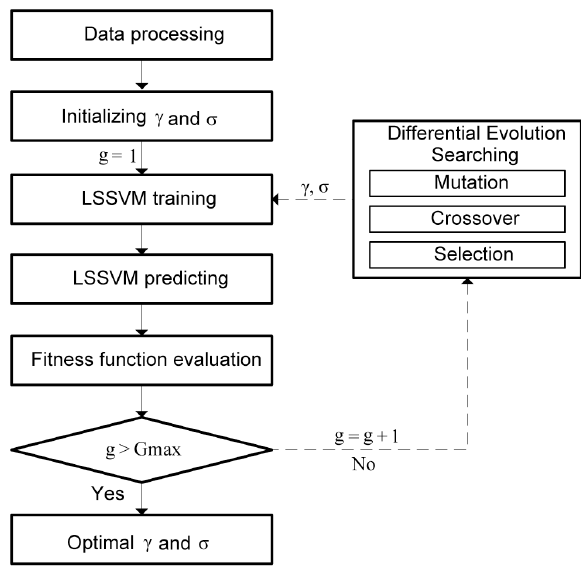
Fig. 4. Differential Evolution based cross-validation process